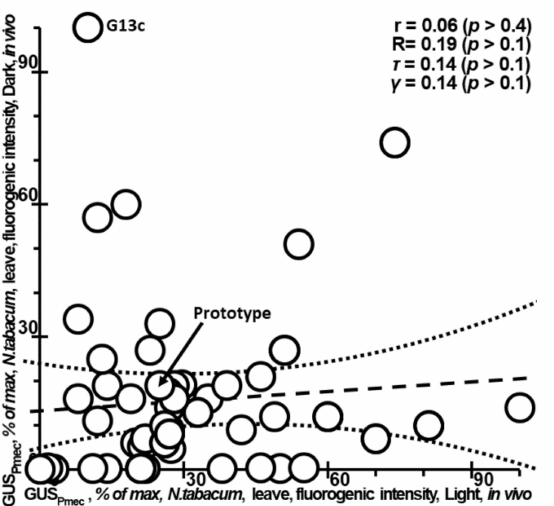
Figure 1. The effects of mutation within the analyzed artificial Pmec promoter on the β -glucuronidase (GUS) activity of tobacco under the experimental conditions “light” ( x -axis) and “dark” ( y -axis) in vivo [53] do not correlate with each other, thereby casting doubt on both the existence and the uniqueness of the uniform estimate for the mutational effects of plant proximal promoters on gene expression under various environmental conditions, usually called an ill-posed inverse problem [61]. Legend : circle, the prototype (arrow, → ), or a mutant variant of the studied artificial promoter Pmec for plants; dashed and dotted lines are linear regression and limits of its 95% confidence interval, as calculated in the Statistica software (Statsoft TM , Tulsa, OK, USA); r, R, τ , γ , and p are the linear correlation, Spearman’s rank correlation, Kendall’s rank correlation, Goodman–Kruskal generalized correlation coefficients, and their statistical significance,